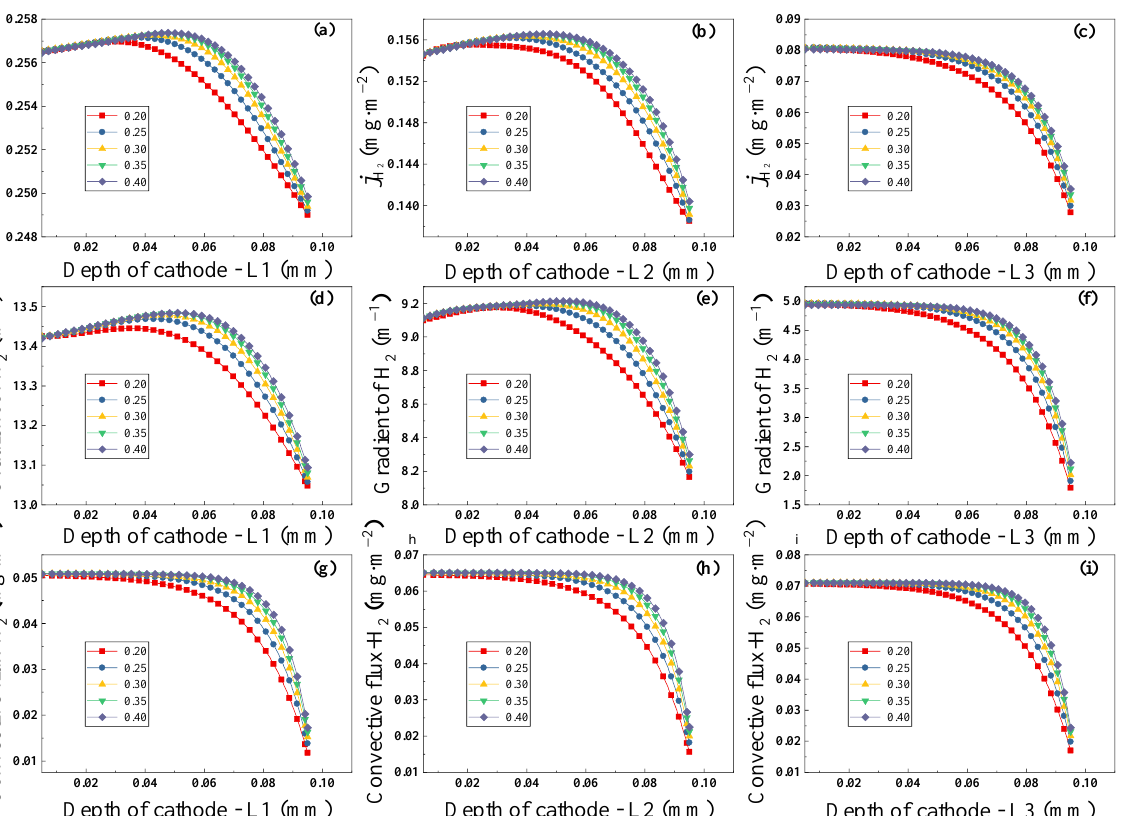
Figure 7. The effect of volume fraction of electrode phase on: ( a – c ) hydrogen molecular diffusion flux; ( d – f ) hydrogen concentration gradient; and ( g – i ) hydrogen convection flux, at L1, L2, and L3.